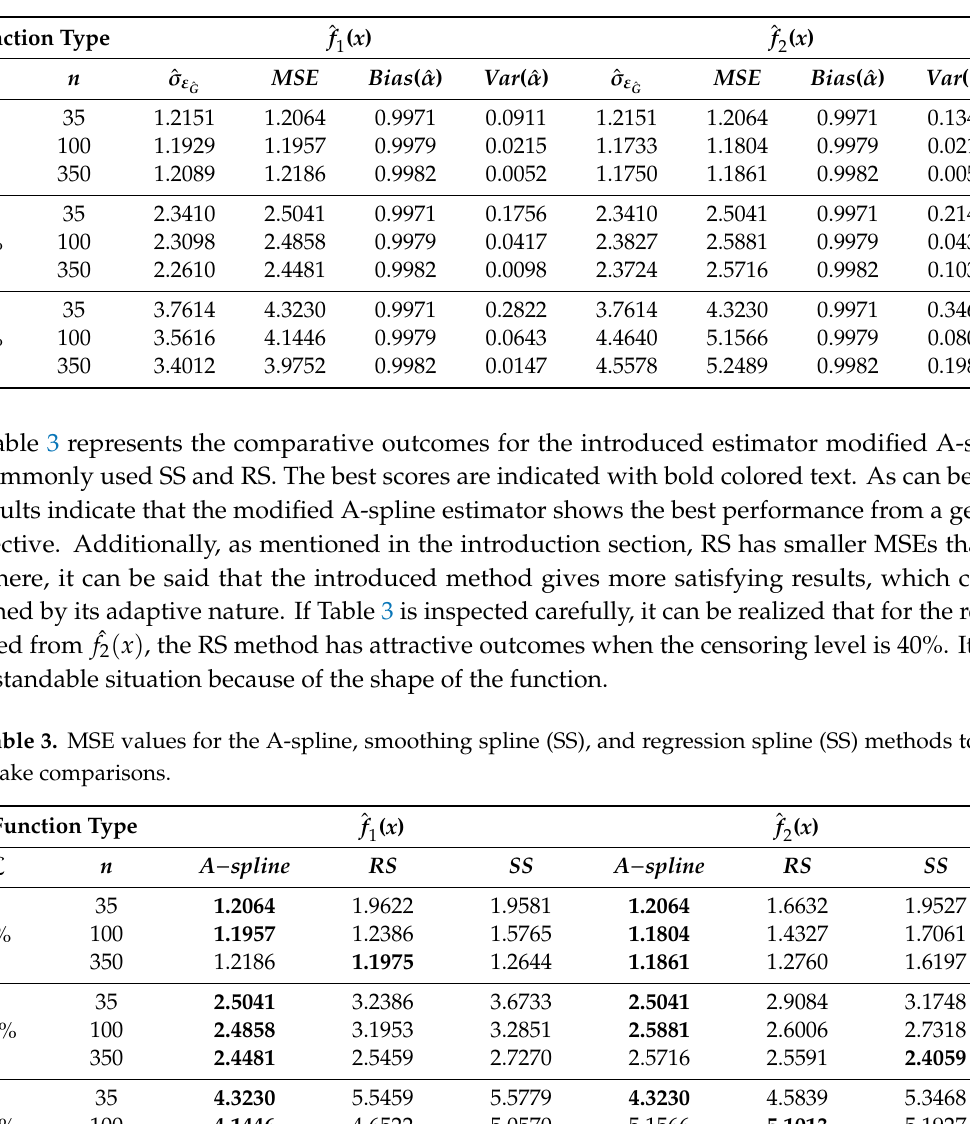
(cid:16) (cid:17) ˆ σ ε , and MSE of ˆ f for all ˆ G